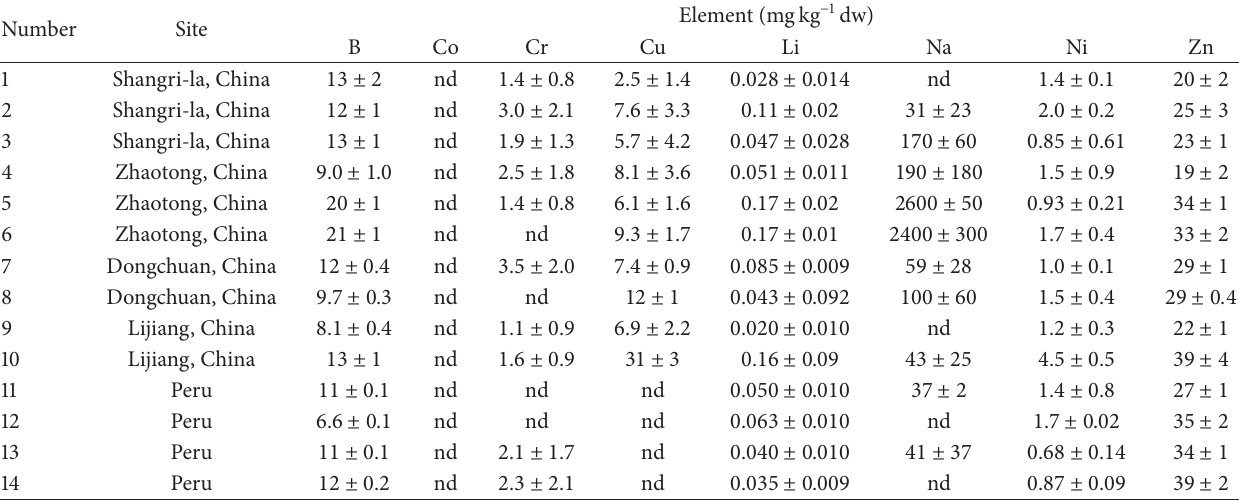
Table 5: Element contents of maca samples, 𝑛 = 3